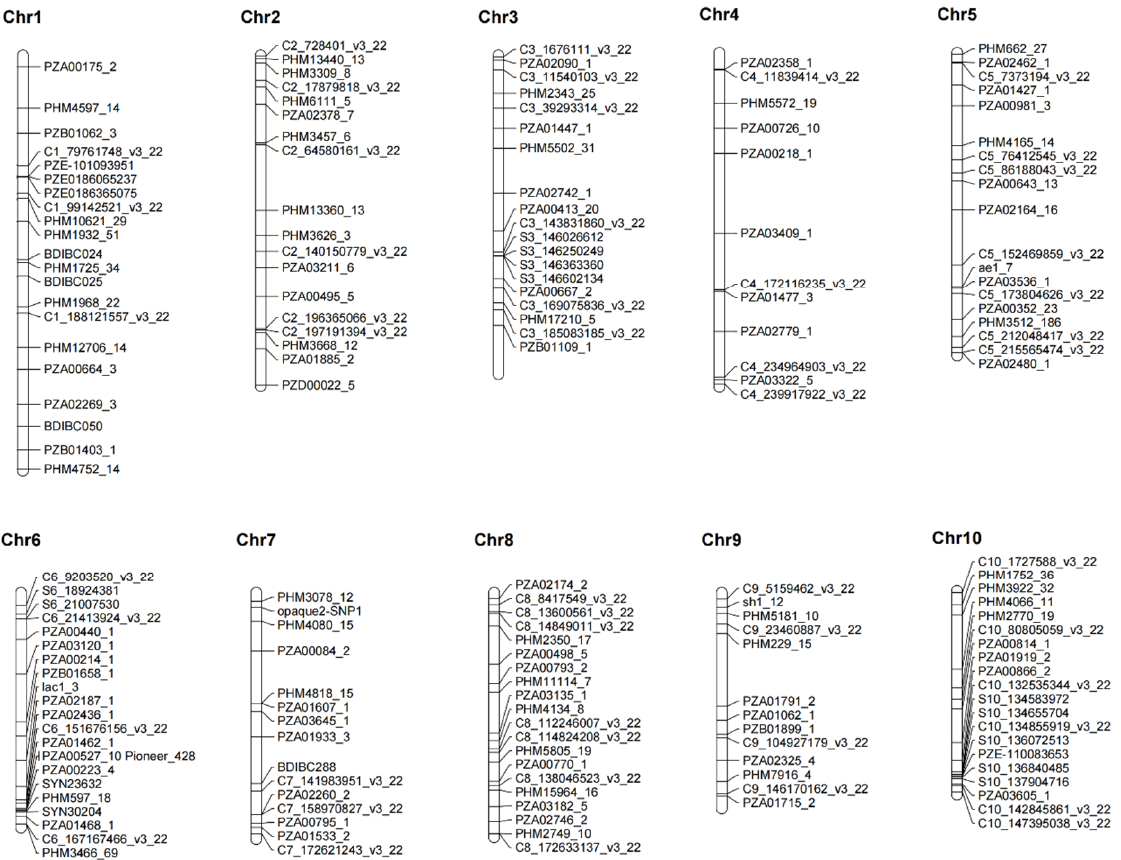
Figure 1. The distribution of 180 SNPs on the ten maize chromosomes. Table 1. Summary statistics for the 180 KASP markers in the first round of genotyping.